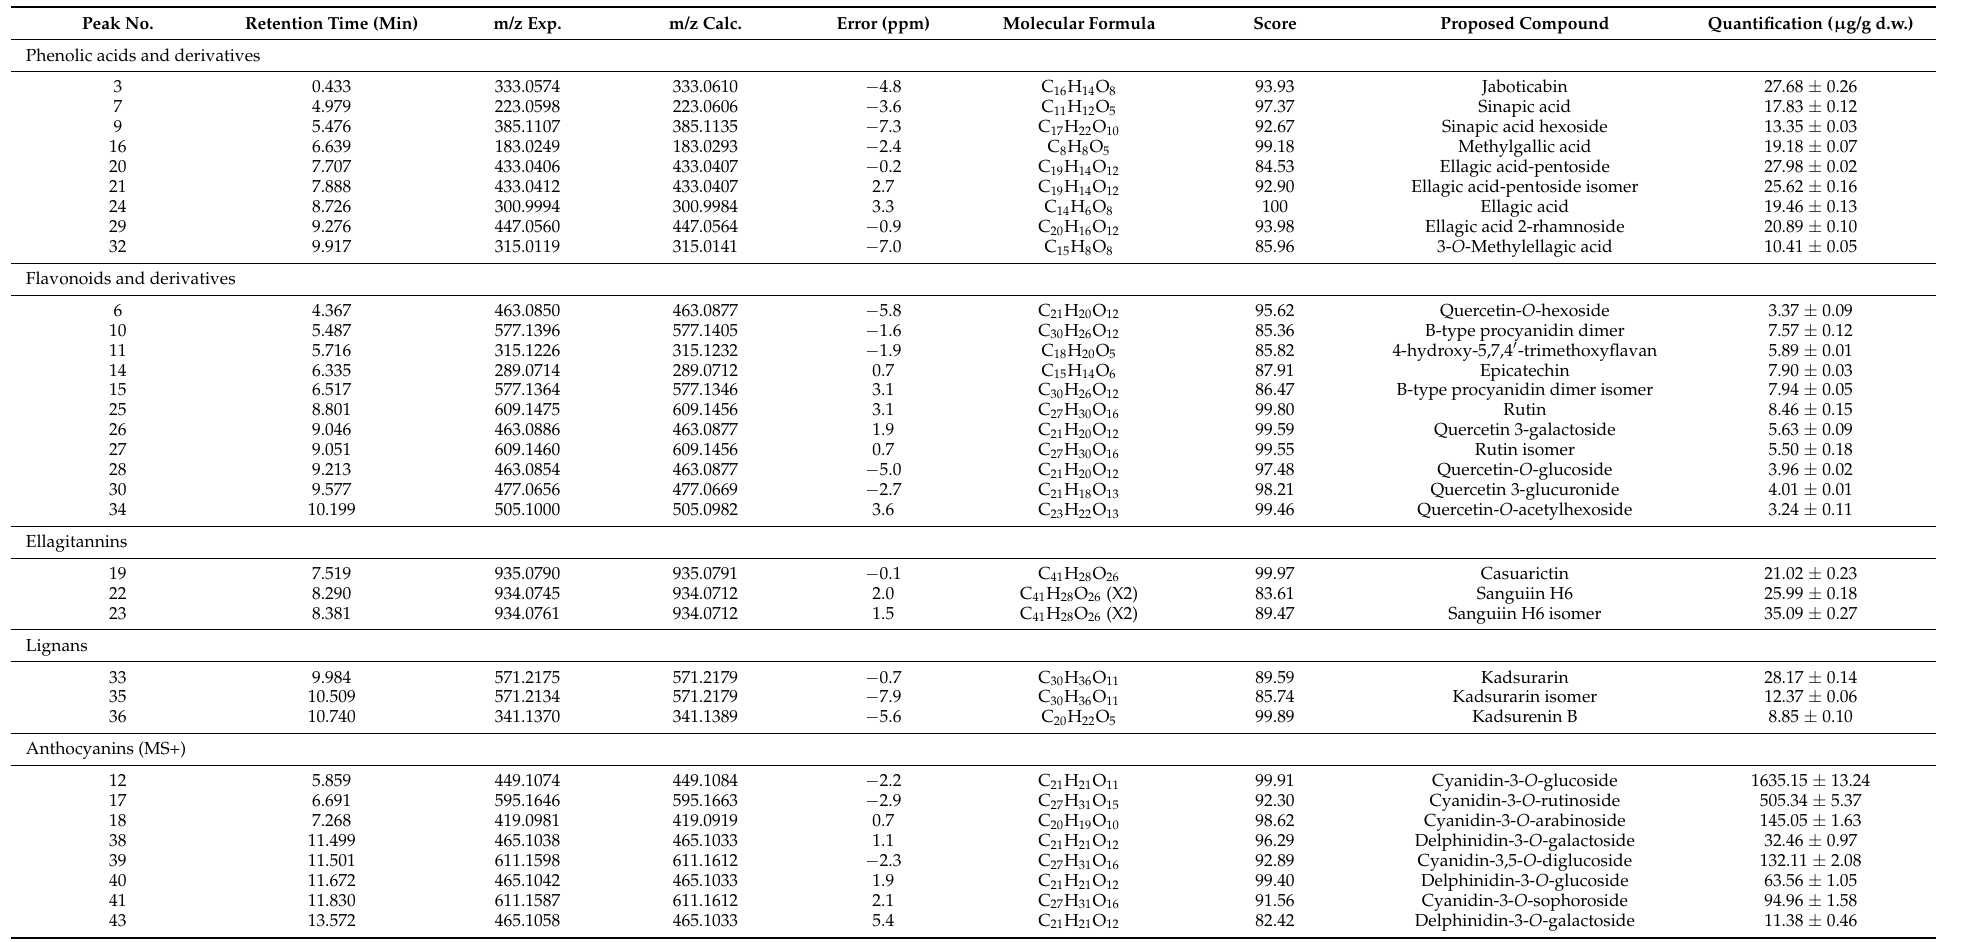
Table 1. Identification and quantification of phenolic compounds present in blackberry